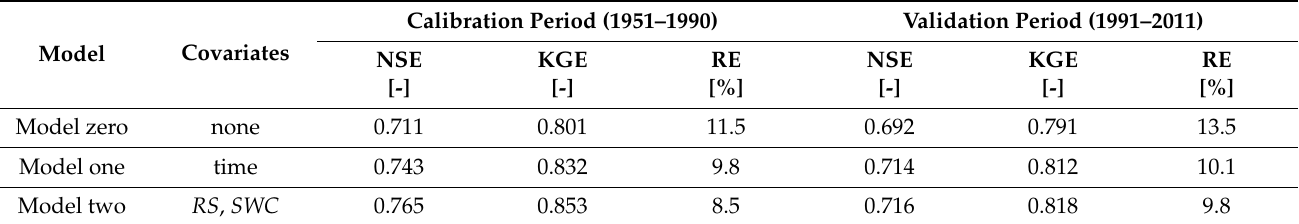
Table 3. Simulation performances of the stationary and nonstationary GR4J model for